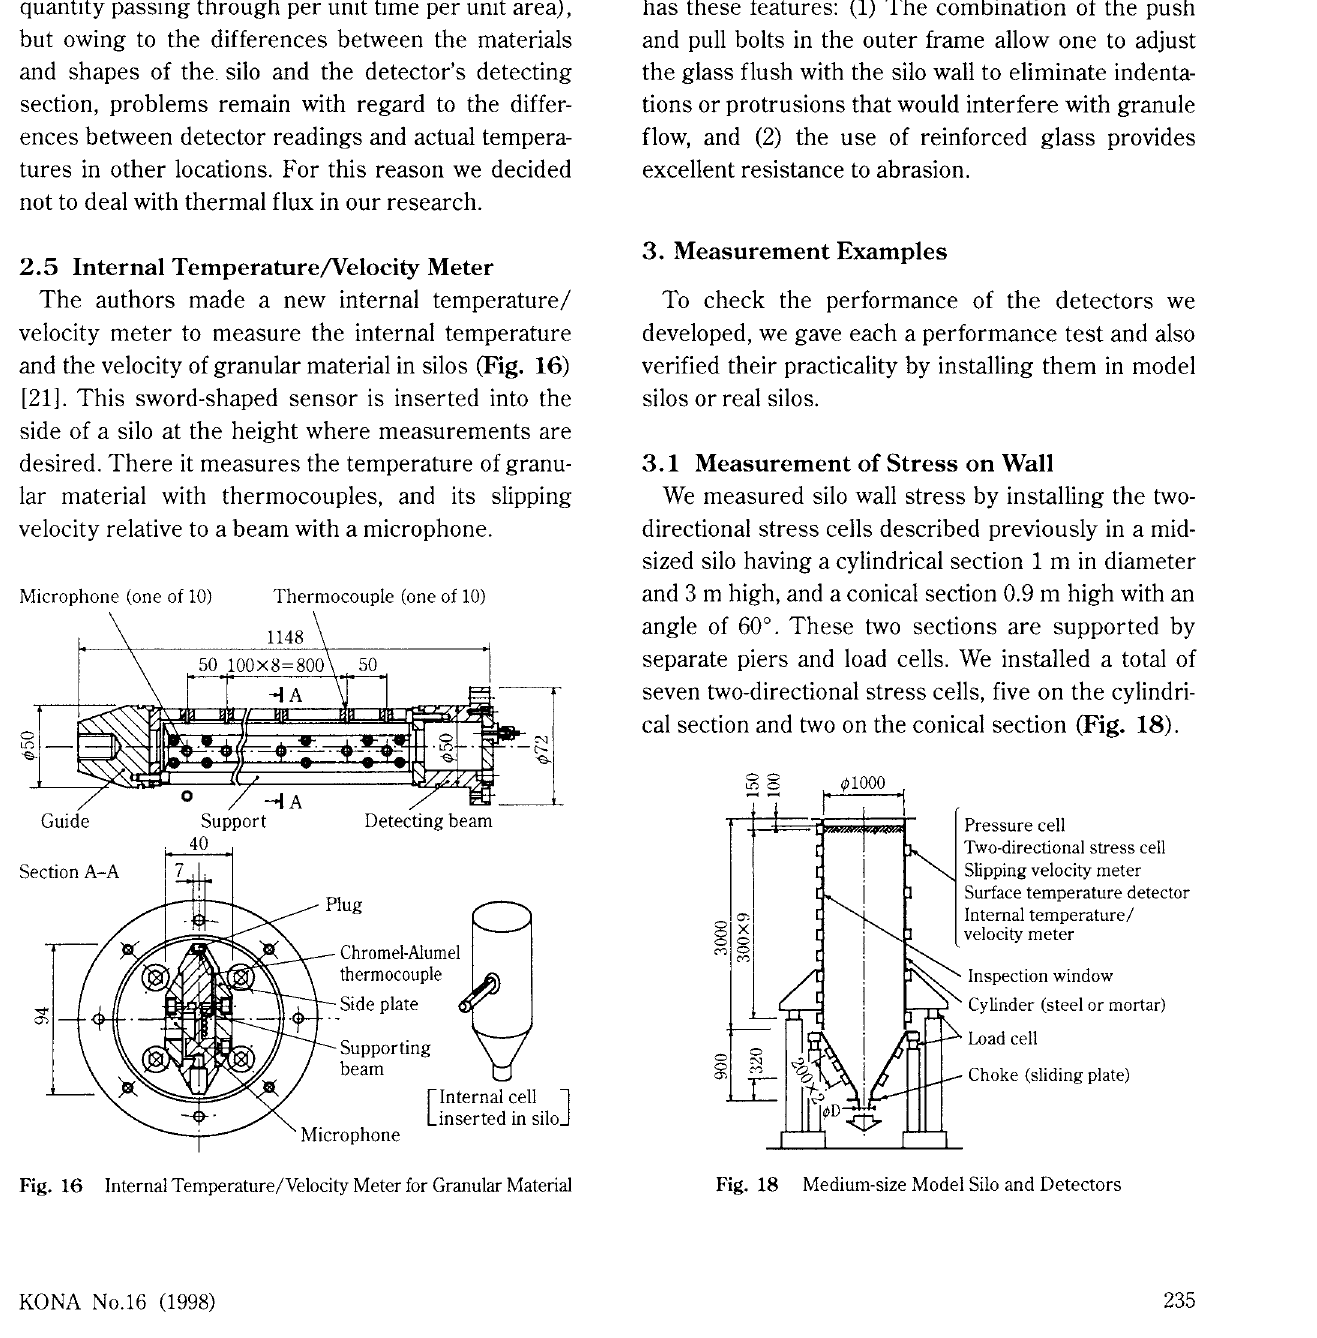
Fig. 16 Internal Temperature/Velocity Meter for Granular Material